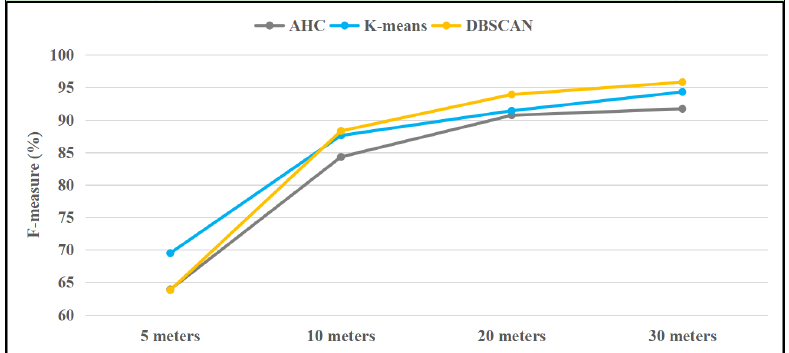
Figure 12. Performance comparison of three typical cluster algorithms.